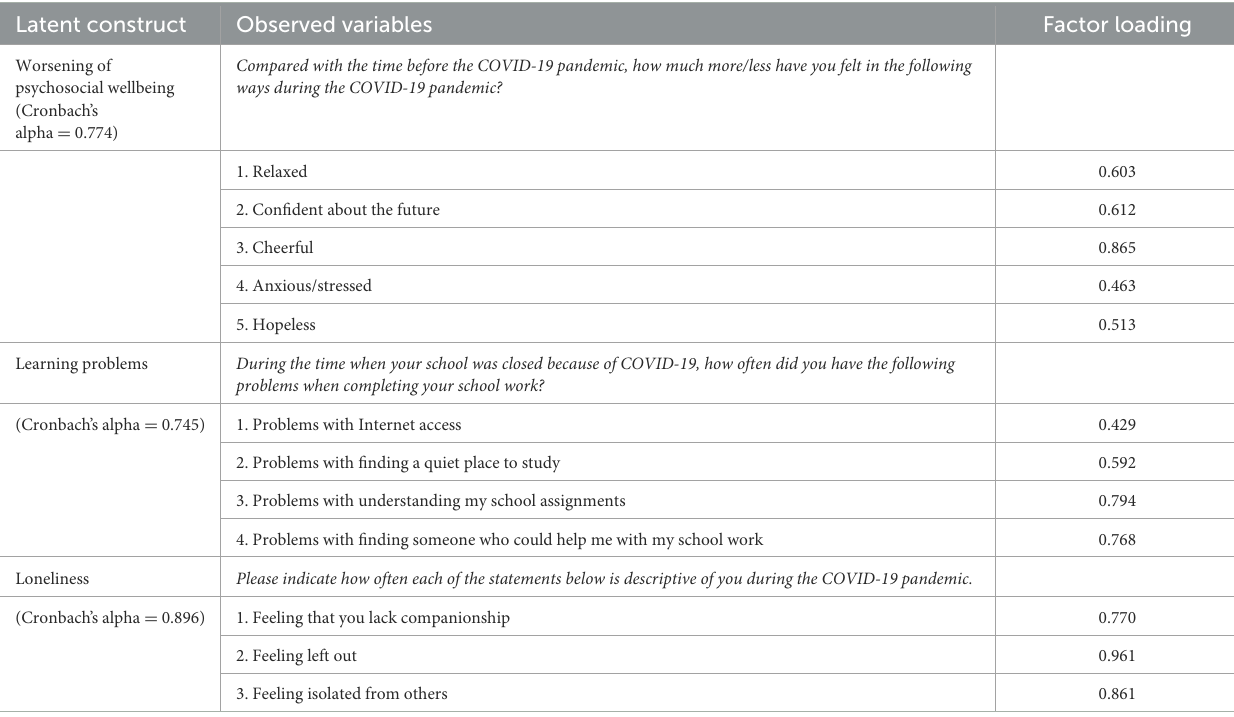
TABLE 2 Standardized factor loadings of observed variables on latent constructs based on separate confirmatory factor